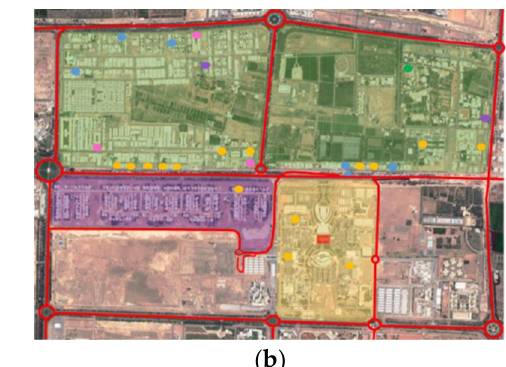
( b ) Figure 3. ( a ) Surrounding building footprint analysis, ( b ) site analysis map. Figure 4. Site images from UAEU campus.